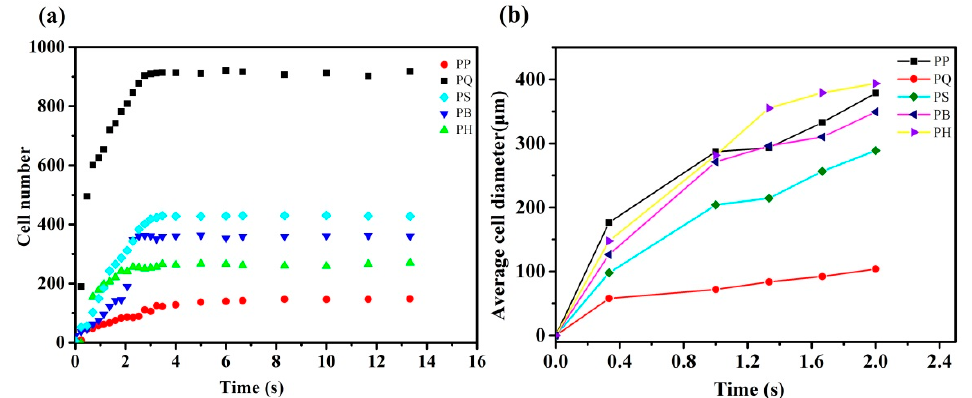
Figure 12. The average cell diameter ( a ) and cell density ( b ) of the foamed PP composites with different times.